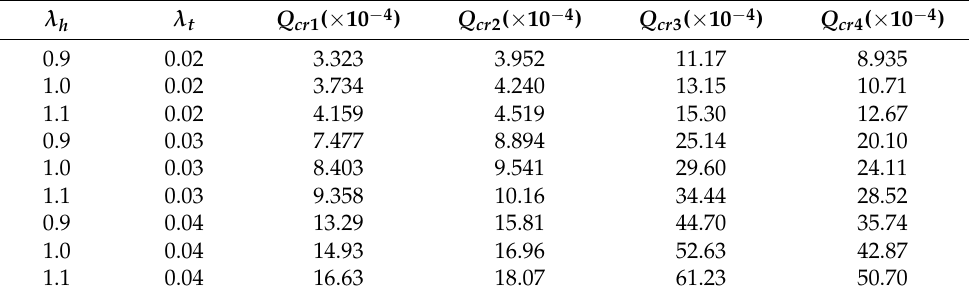
Table 8. Four critical loads under different λ h and λ t ( β = ± 0.3 ).